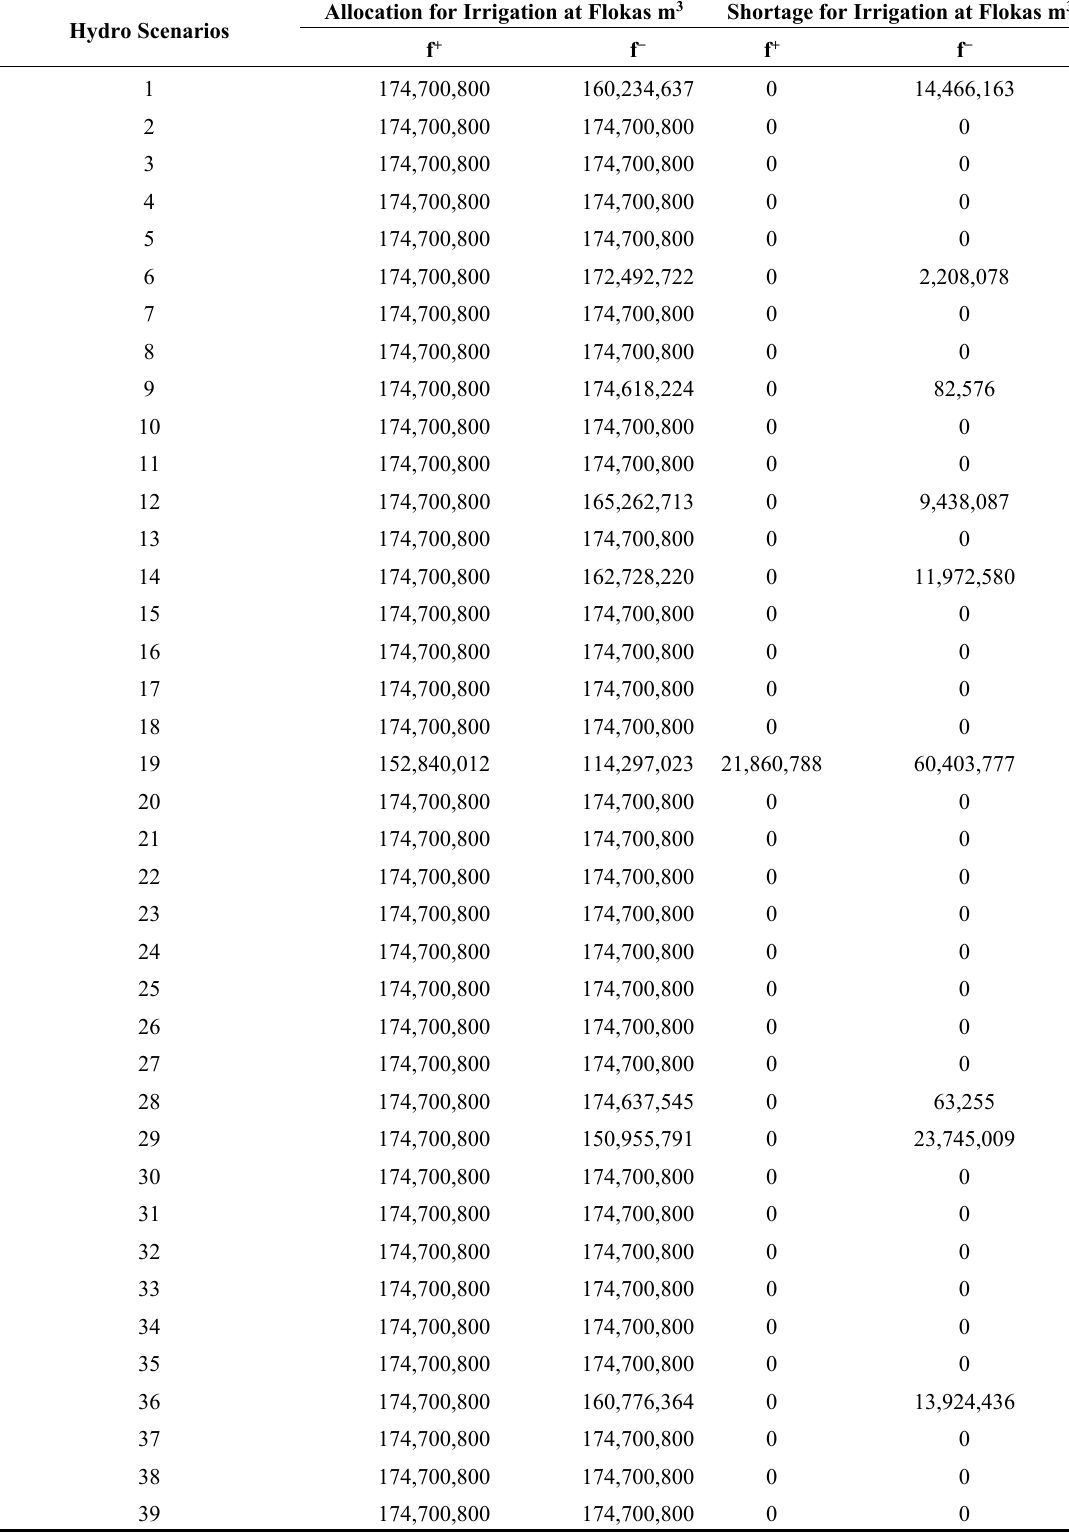
Table 17. Annual water allocation and shortage for irrigation at Flokas (m 3